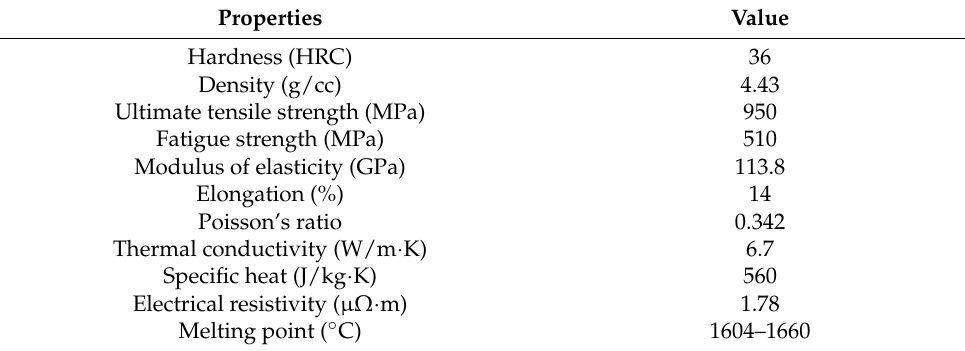
Table 1. Properties of the Ti-6Al-4V alloy